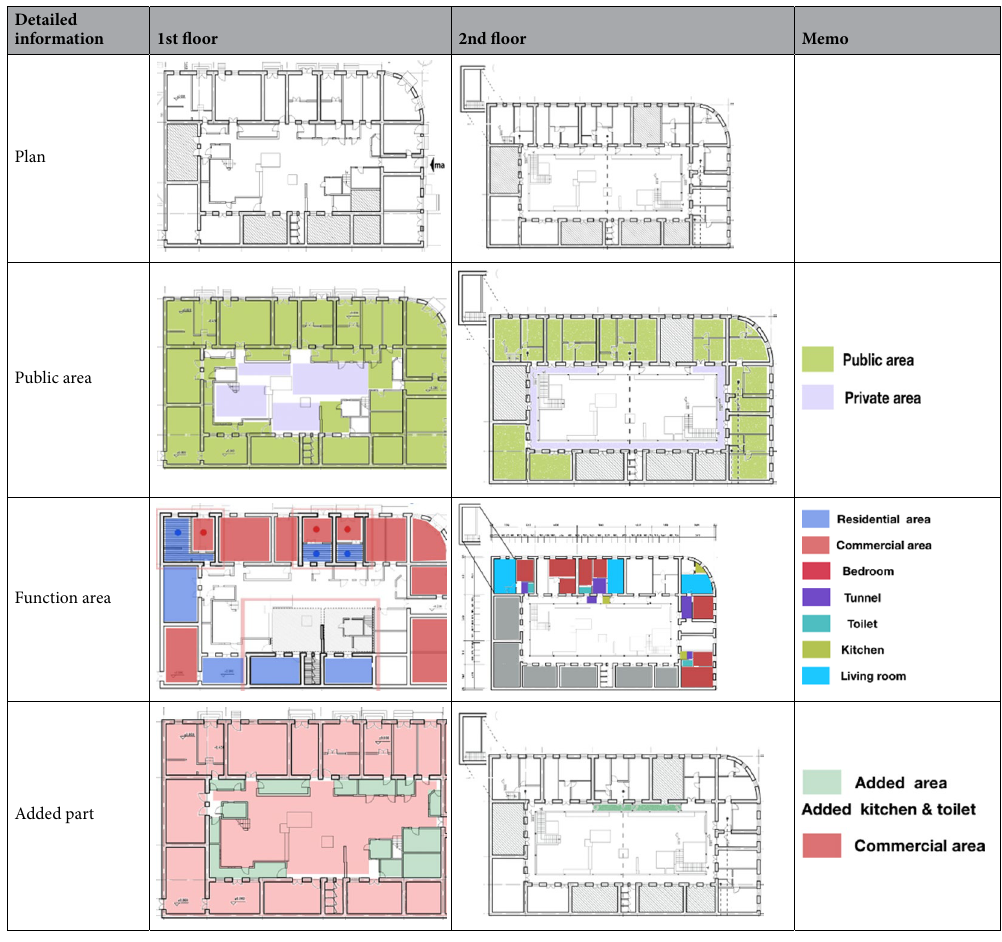
Table 2. The layout analysis of the